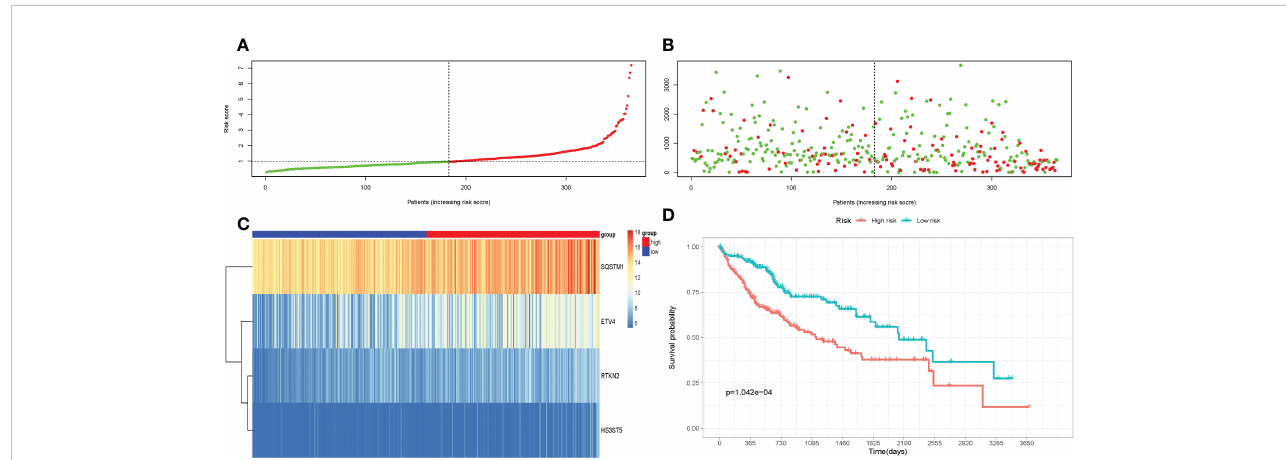
FIGURE 3 Construction of the super enhance based prognostic risk signature in the TCGA cohort. (A) The risk score distribution of HCC patients; (B) Survival status and duration of patients; (C) Heatmap of the expression of the immune-related genes; (D) Survival curves for the low-risk and high-risk